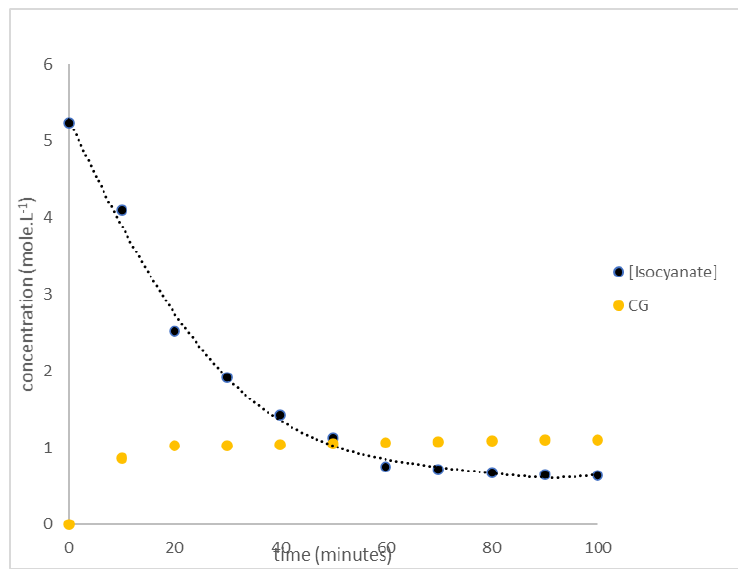
Figure 9. The decreasing isocyanate concentration and increasing diazene oxide concentration following hexogen coating with IPDI.